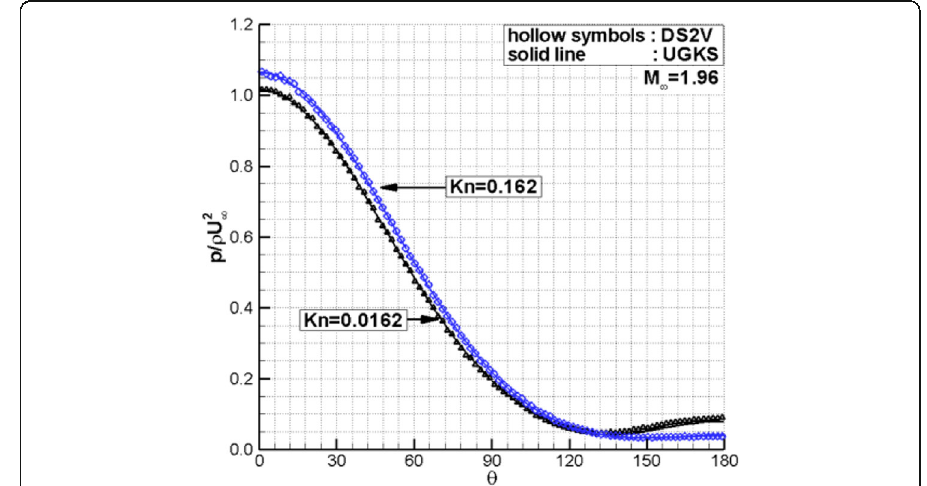
Fig. 12 Pressure distributions on the cylinder surface at M =